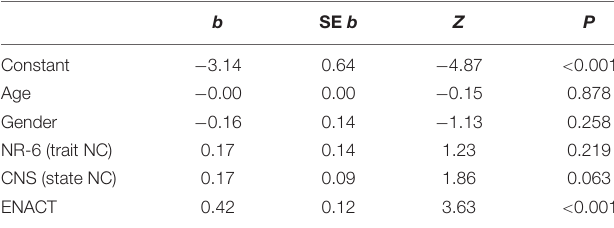
TABLE 5 | Logistic regression model 3 for predicting behavior after 1 month ( N =